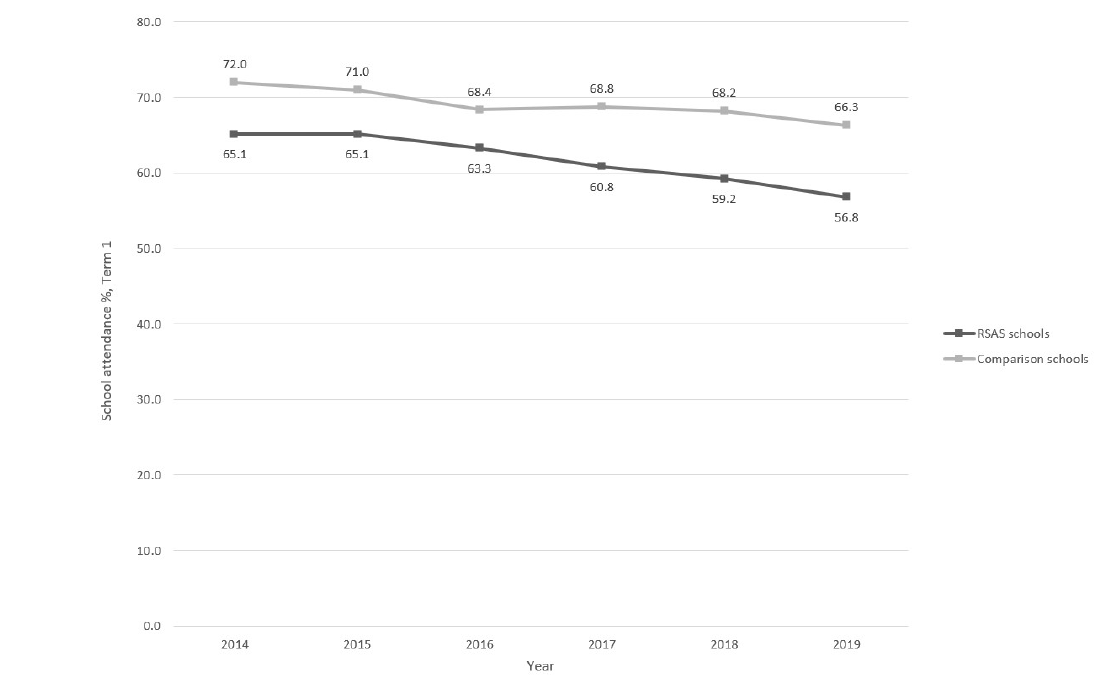
Figure 2: Attendance trajectories for Very Remote schools with and without an RSAS program (with >80% First Nations student enrolments) Term 1